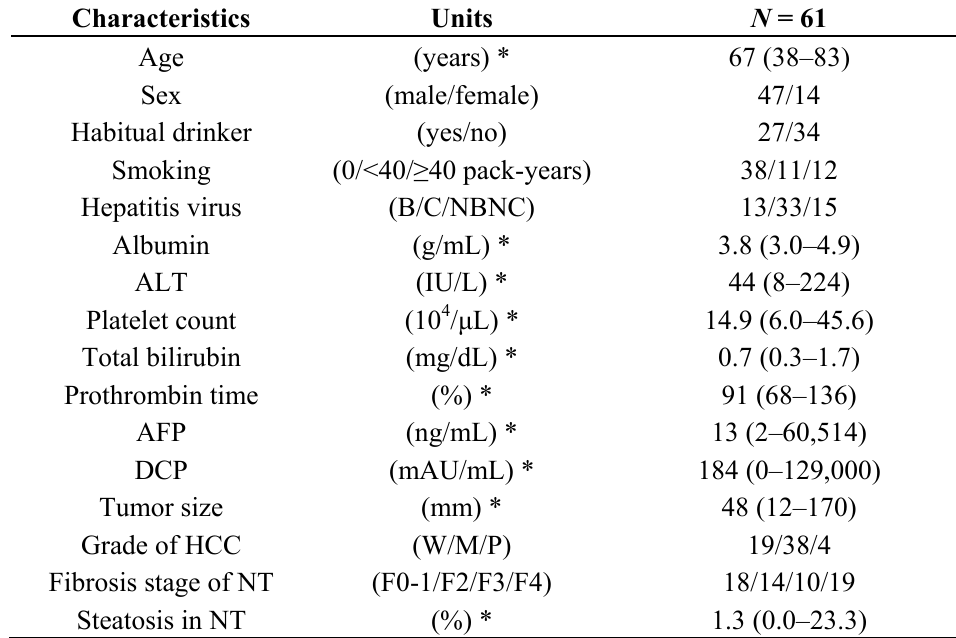
Table 1. Clinicopathological characteristics of patients included in this